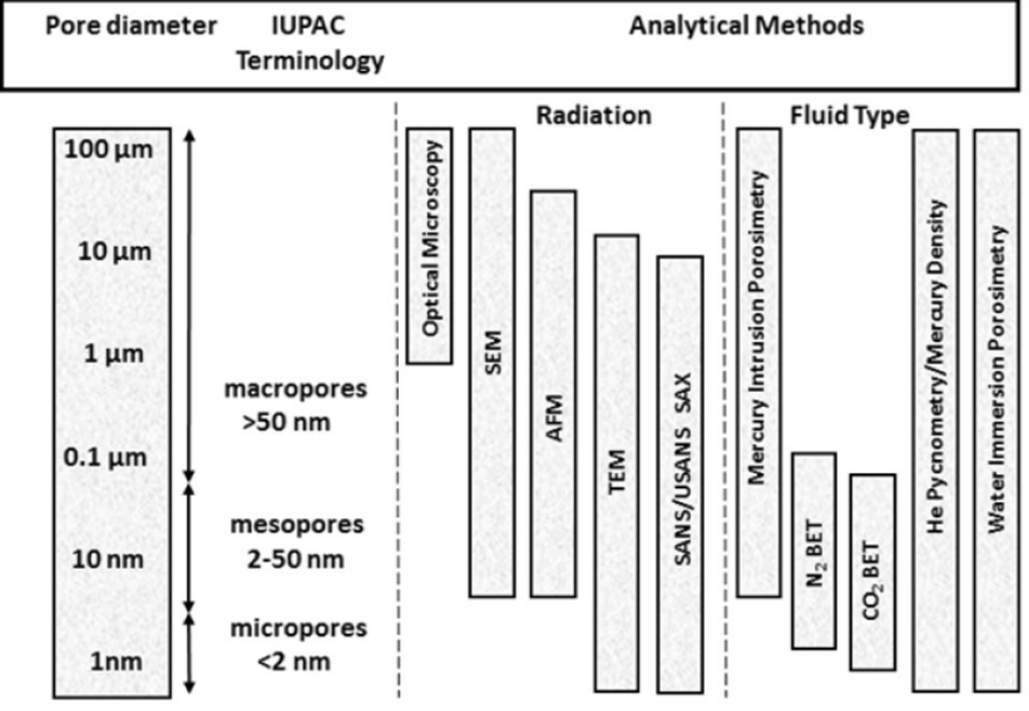
Figure 2. Methods used for measurements of porosity and pore size distribution.